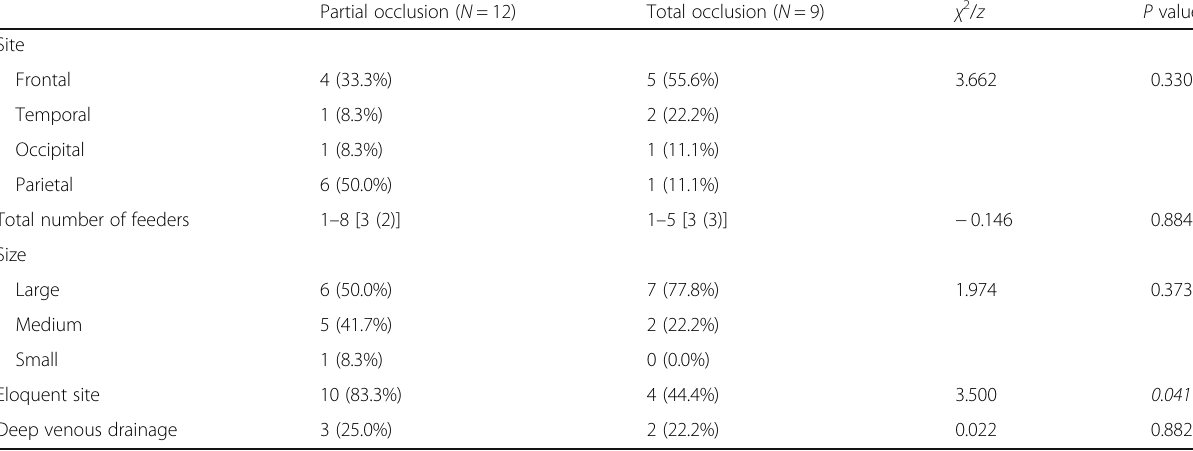
Table 4 Comparison between totally occluded AVMs and partially occluded